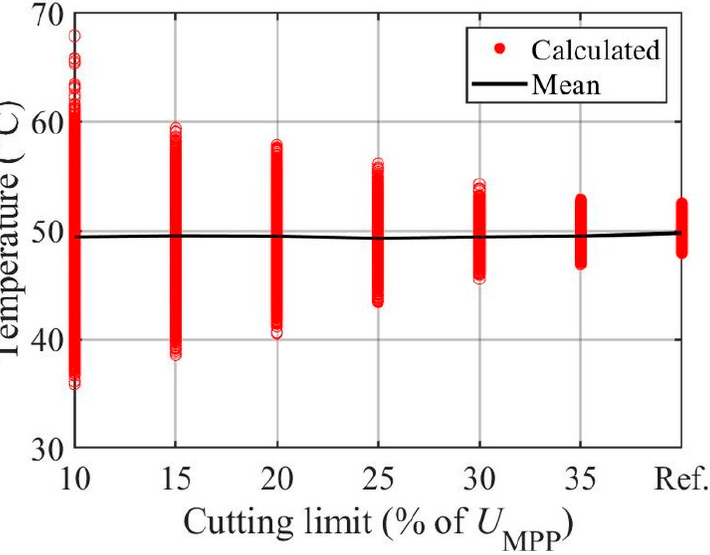
Figure 14. Fitted temperature values during the 40 min measurement period as a function of the cutting limit based on MPP voltage.